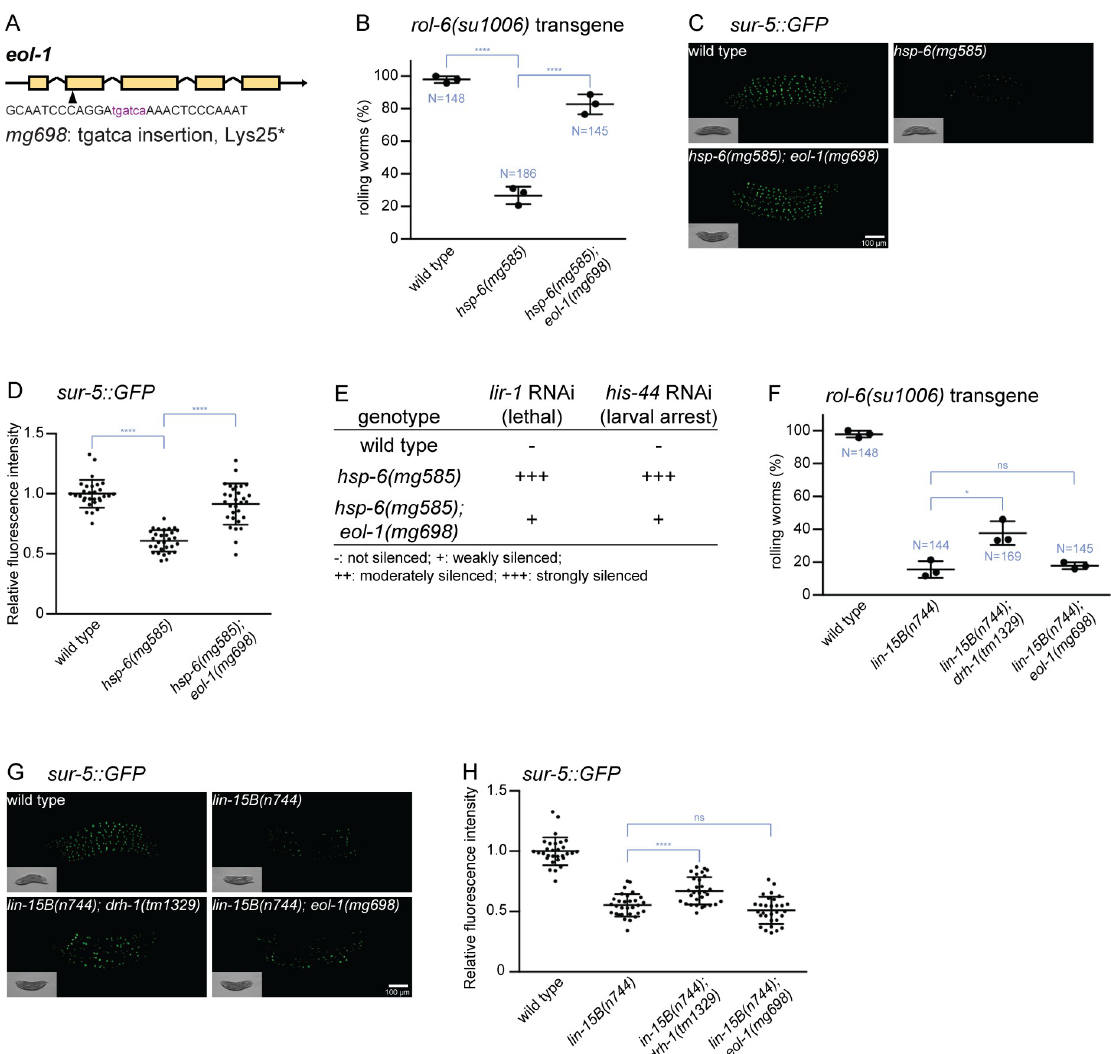
Fig 3. EOL-1 gene activity is required for Eri. (A) The eol-1(mg698) mutant allele generated by CRISPR-Cas9. (B) Transgene silencing test with the rol-6(su1006) multicopy transgene. The expression of the rol-6 collagen mutation from the transgene is silenced by the Eri in the hsp-6(mg585) mutant, and this transgene silencing depends on eol-1 gene activity. Results of 3 replicate experiments are shown. N : total number of animals tested; ���� denotes p < 0.0001. (C and D) Transgene silencing test with sur-5 :: GFP transgene. This transgene was ubiquitously expressed in all somatic cells. The expression of the sur-5 :: GFP from the transgene is silenced by Eri in the hsp-6(mg585) mutant, and this transgene silencing requires eol-1 . Animals were imaged in (C), and the fluorescence was quantified in (D). ���� denotes p < 0.0001. (E) Eri response to lir-1 RNAi or his-44 RNAi in hsp-6(mg585) mutant requires eol-1 . RNAi of lir-1 or his-44 causes lethality/ arrest on hsp-6(mg585) mutant but not wild type. The Eri is suppressed by the eol-1(mg698) mutation. (F) Silencing of rol-6(su1006) transgene caused by synMuvB Eri mutations does not depend on eol-1 . The rol-6(su1006) transgene is silenced by the synMuvB lin-15 (n744) mutation, and this transgene silencing was slightly suppressed by drh-1(tm1329) , but not by eol-1(mg698) . Results of 3 replicate experiments are shown. N : total number of animals tested; � denotes p < 0.05; ns denotes p > 0.05. (G and H) Silencing of sur-5 :: GFP transgene caused by synMuvB Eri mutations does not require eol-1 . The sur-5 :: GFP transgene is silenced by the synMuvB lin-15(n744) mutation, and this transgene silencing was slightly suppressed by drh-1(tm1329) , but not eol-1(mg698) . Animals were imaged in (G) and the fluorescence was quantified in (H). ���� denotes p < 0.0001; ns denotes p > 0.05. The underlying numerical data can be found in S1 data. Eri, enhanced RNAi; ns, not significant; RNAi, RNA interference.